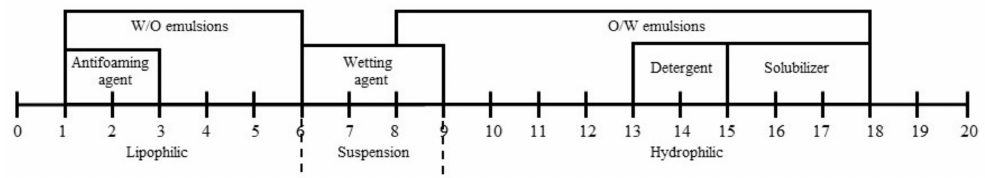
Figure 4. The application of surfactants according to their hydrophile–lipophile balance values